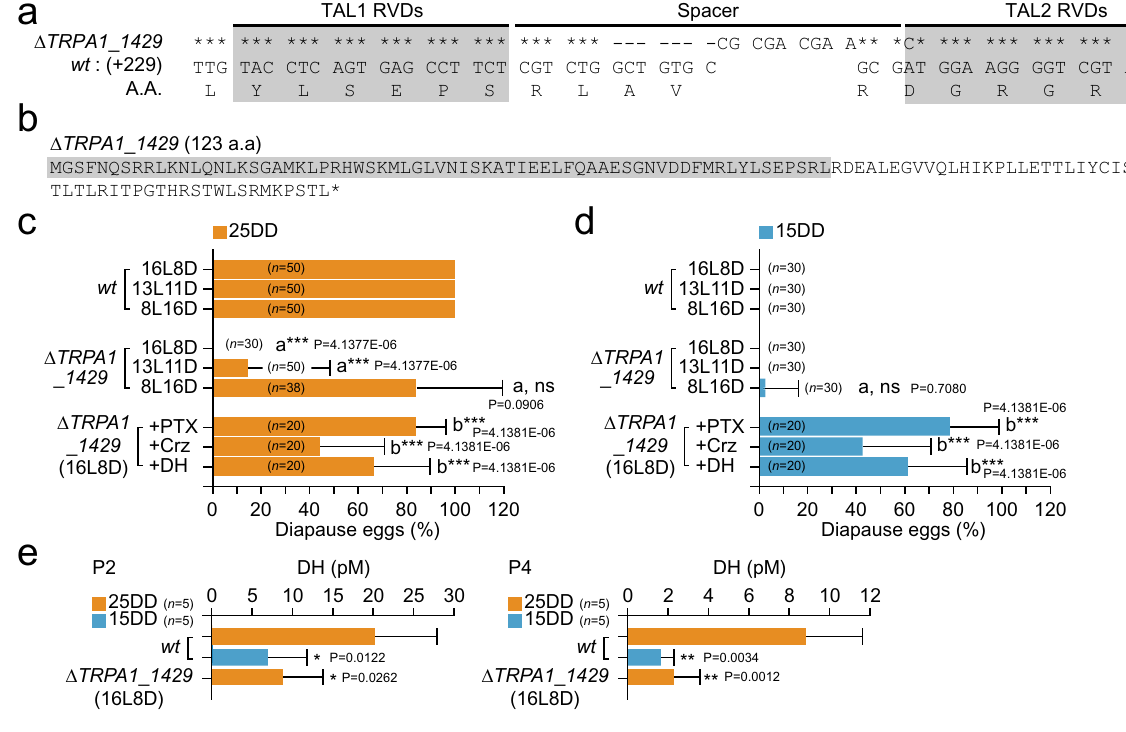
Figure 4. Knockout (KO) mutant of BmoTRPA1 . ( a ) Gray boxes indicate the sequences of the TALEN target sites. The sequence of the BmoTRPA1 gene of the mutant line ∆TRPA1_1429 that inserted, deleted, and replaced 17 bases between the spacer region and right TALEN binding site (TAL2 RVDs) are indicated. Asterisks indicate the bases identical to wild type ( wt ) sequences. ( b ) The ∆TRPA1_1429 gene encodes a truncated protein consisting of 123 amino acids. ( c , d ) Diapause egg-inducing activity in ∆TRPA1_1429 . The proportions of diapause eggs oviposited from wt and KO mutant female moths of 25DD ( c ) and 15DD ( d ) were measured as well as that of moths injected with plant alkaloid picrotoxin (PTX), corazonin (Crz), and diapause hormone (DH) at 50 µg, 1 nmol, and 100 pmol/pupa, respectively. Significant differences versus wt (a) or non-injected silkworm on 16L8D (b) were evaluated. ( e ) DH levels in hemolymph 2 (P2) and 4 (P4) d after pupation in both wt and ∆TRPA1_1429 . Significant differences versus wt (25DD) were evaluated. ns, non-significant; *, P < 0.05; **, P < 0.01; ***, P <